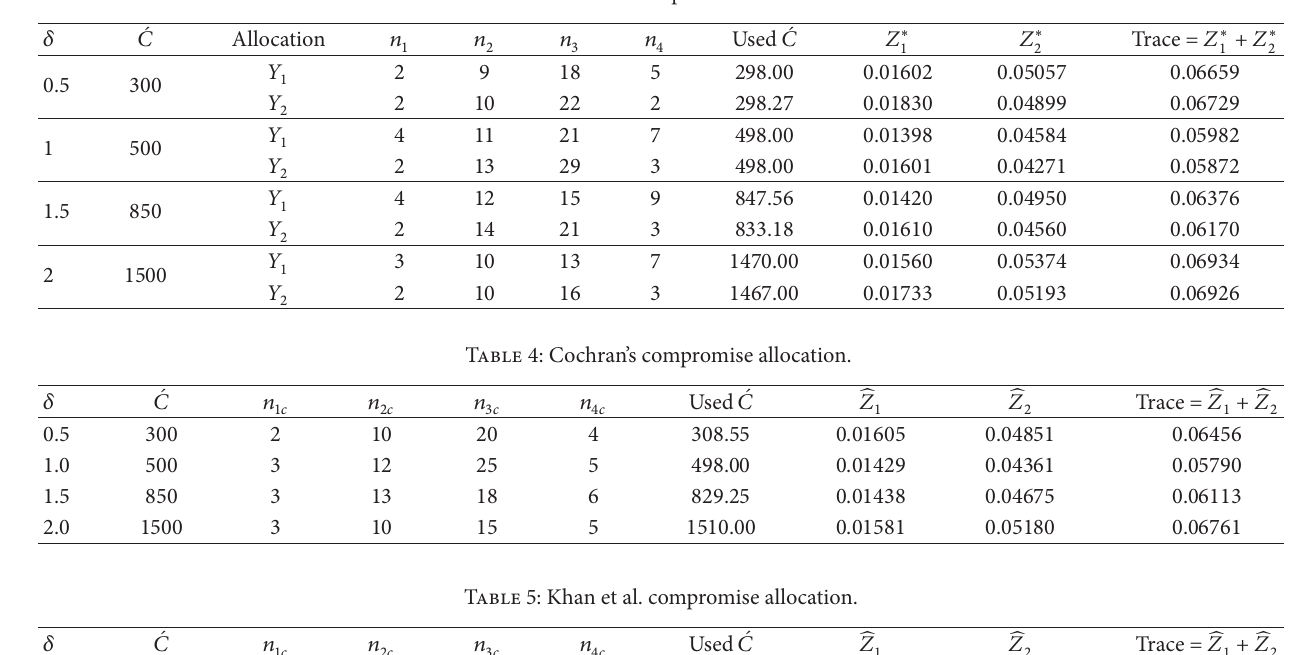
Table 3: Individual optimum allocation.